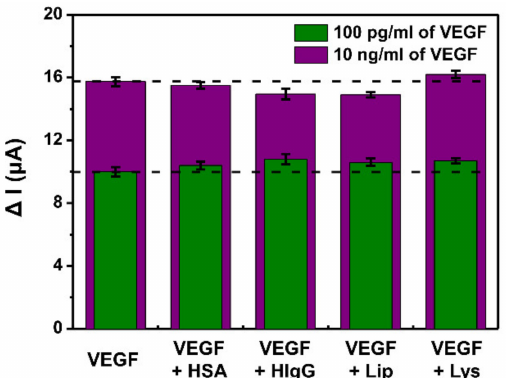
Figure 7. Selectivity of the PANI/CNT/Apt-modified electrodes shown in ∆ I scales for VEGF 165 in the presence of 100 times of HSA, HIgG, Lip, and Lys as the interfering species. The concentrations of VEGF 165 are 100 pg/mL and 10 ng/mL and the interfering species are 10 ng/mL and 1 µ